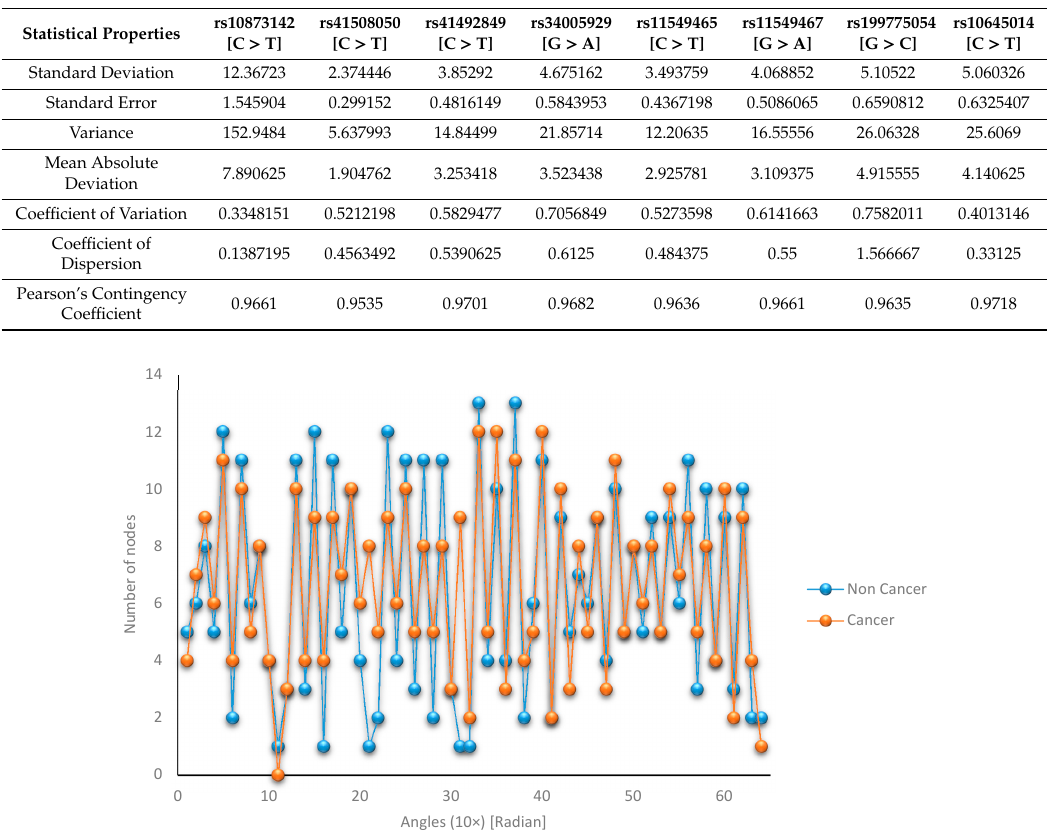
Figure 7. Comparison graph Γ ( ϕ i , j ) of sequence ( ϕ i , j ) from DNA sequences between non cancer and cancer rs10873142 [C > T].